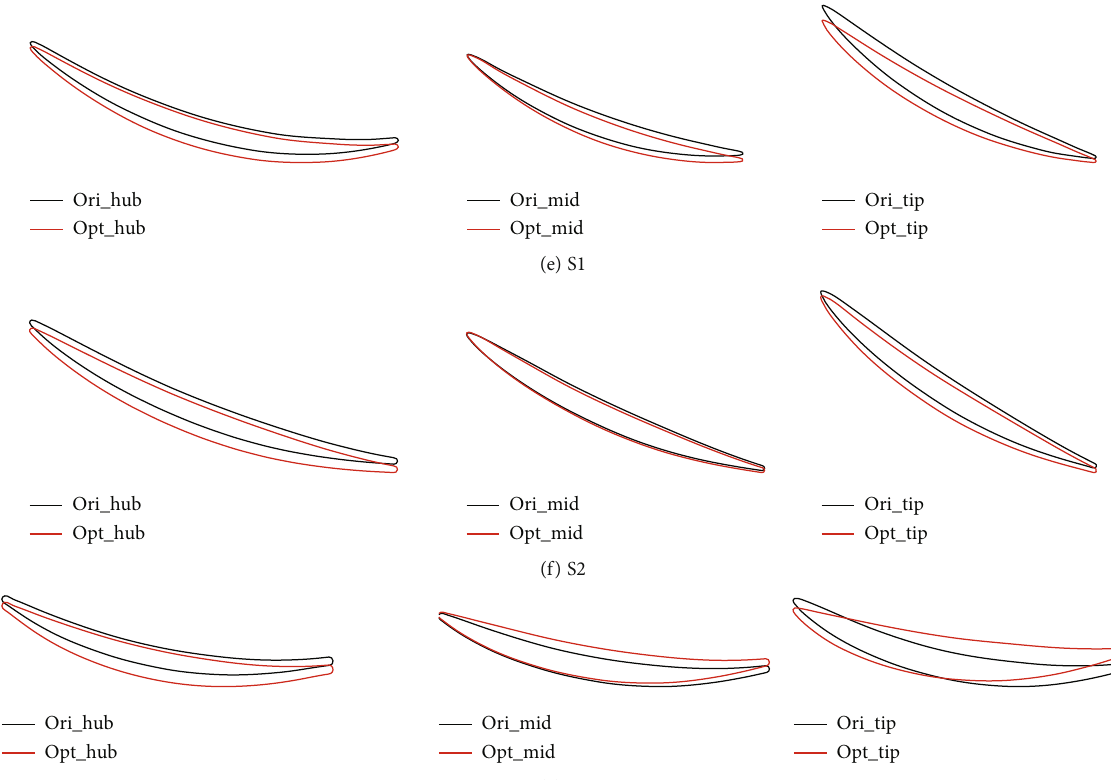
Figure 14: Geometric changes before and after